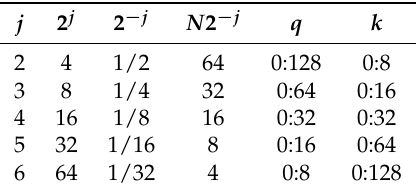
Table 3. Example of the dyadic sampling scheme for a signal of length 128 and ∆ =